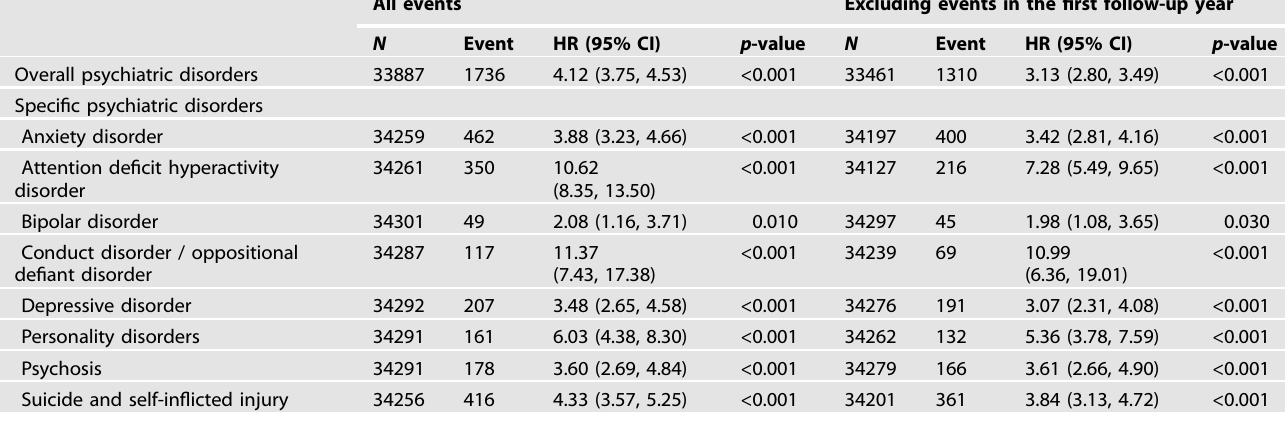
Table 2. Associations of childhood maltreatment with overall and speci fi c psychiatric